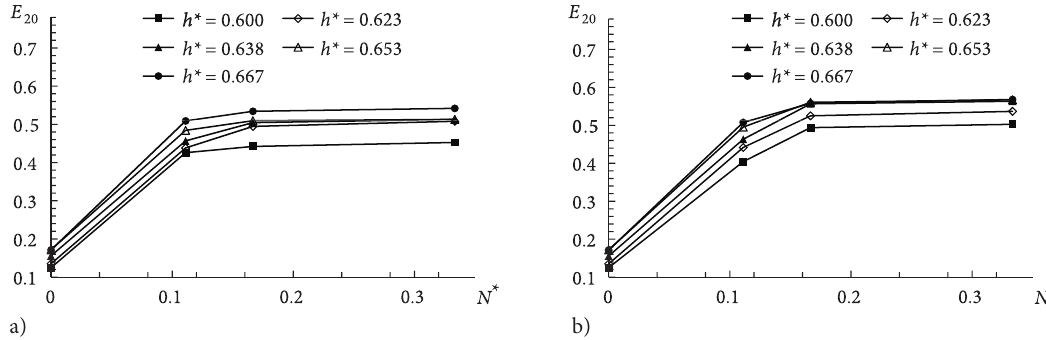
spillwaysa) Fig. 8. Variation of E with N * when Q = 0.4 l/s in: (a) parallel flashboard spillways; (b) interlaced flashboard 20